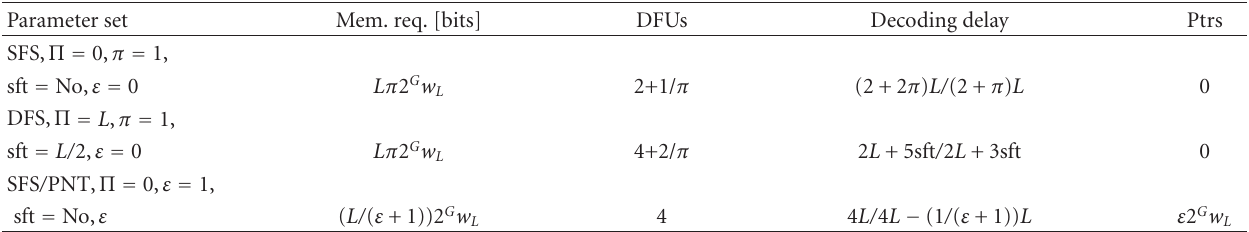
Table 3: Complexity and decoding delay of best SW